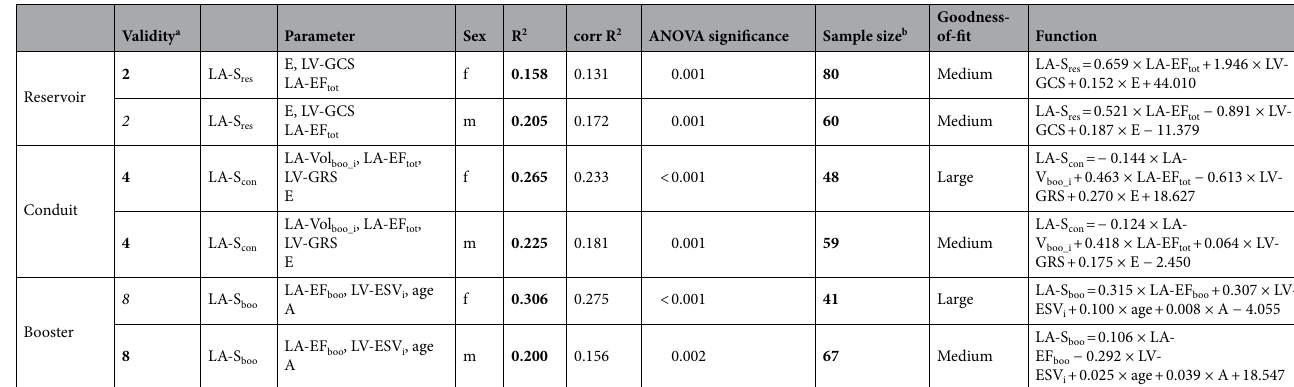
Table 6. Multilinear regression analysis to study multifactorial influences of left atrial strain. Analysis was done on the total study group. A sub-selection is shown. A comprehensive summary of all testings is provided in the supplement online. In order to be able to carry out a multilinear regression analysis, it is mandatory to check the prerequisites in advance. These are (a) linear relationships between the variables, (b) no outliers, (c) independence of the residuals, (d) no multicollinearity, (e) homoscedasticity and (f) normal distribution. a Bold = prerequisites are met; italics = valid, but with fewer concerns due to the prerequisites (e.g. an outlier had to be removed or the independence of the residuals had not reached the optimal value of ~ 2 before the analysis). Number of females = 97; number of males = 86. Interpretation of |R 2 | according to Cohen. [Cohen, J. (1988). Statistical power analysis for the behavioral sciences (2nd ed.). Hillsdale, N.J.: L. Erlbaum Associates. Page 412 ff.]. Small effect size:|R 2 |= 0.02; medium effect size |R 2 |= 0.13; large effect size |R 2 |= 0.26. b Sample size calculation see reference [Calculation according to Hemmerich, W. (2019). StatistikGuru: Poweranalyse und Stichprobenberechnung für Regression. Retrieved from https:// stati stikg uru. de/ rechn er/ power analy se-